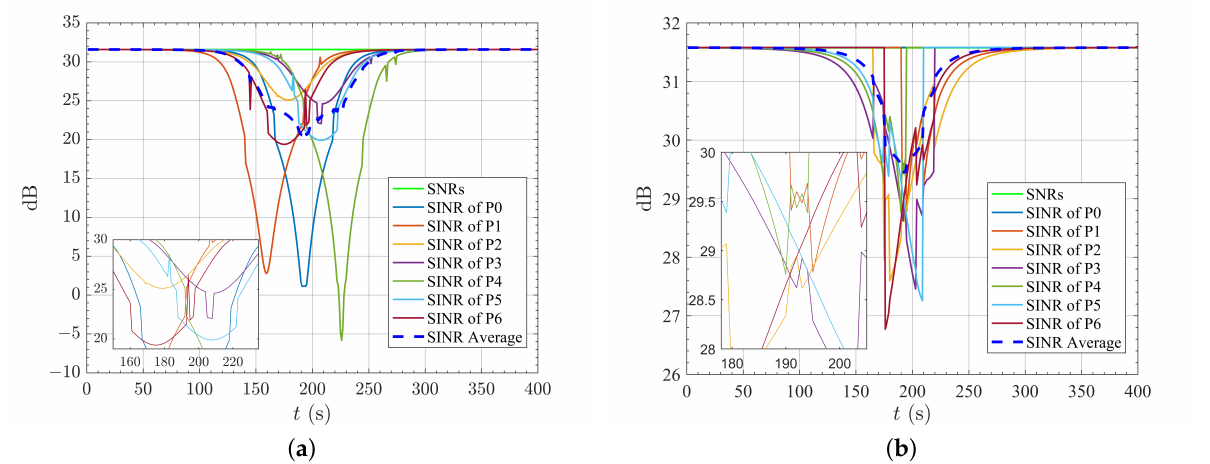
Figure 9. SNR and SINR of different GSO ground stations in different beams for the seven-beam scenario without and with channel allocation. ( a ) SNR and SINR of different GSO ground stations in different beams for the seven-beam scenario without channel allocation; ( b ) SNR and SINR of different GSO ground stations in different beams for the seven-beam scenario with channel